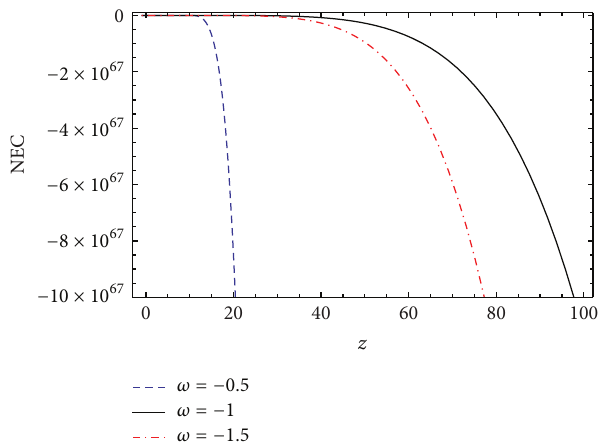
Figure 8: Evolution of NEC for reconstructed 𝑓(𝑇) in quintessence model for Ω 𝑚0 = 0.315 and 𝐻 0 = 67.3 .